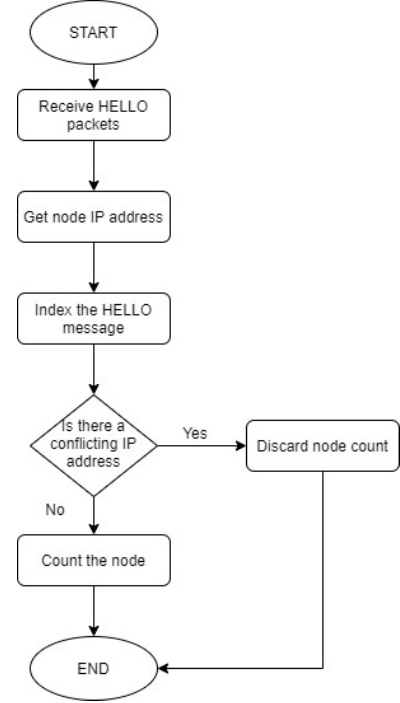
Figure 3. Indexing the HELLO messages and counting the corresponding node.